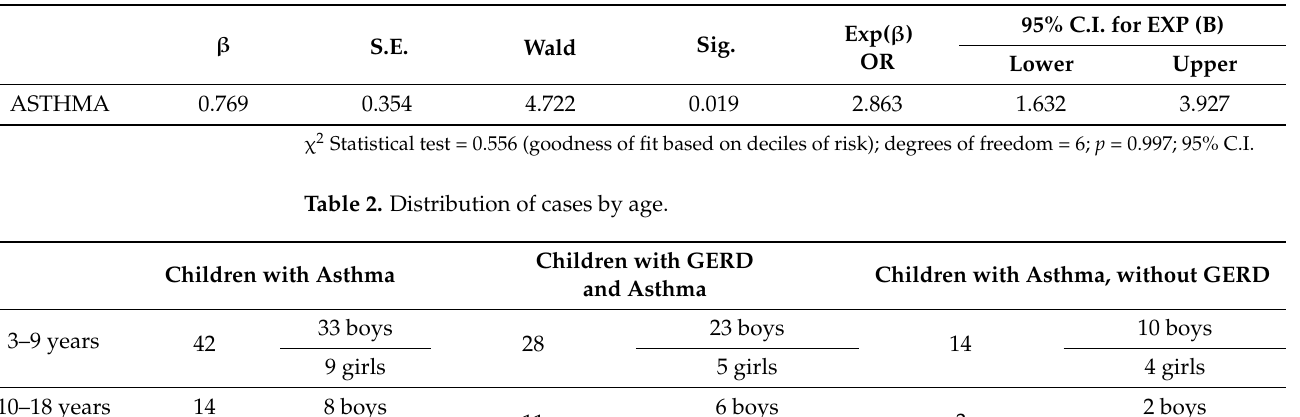
Table 1. Coefficients and Wald tests for logistic regression.